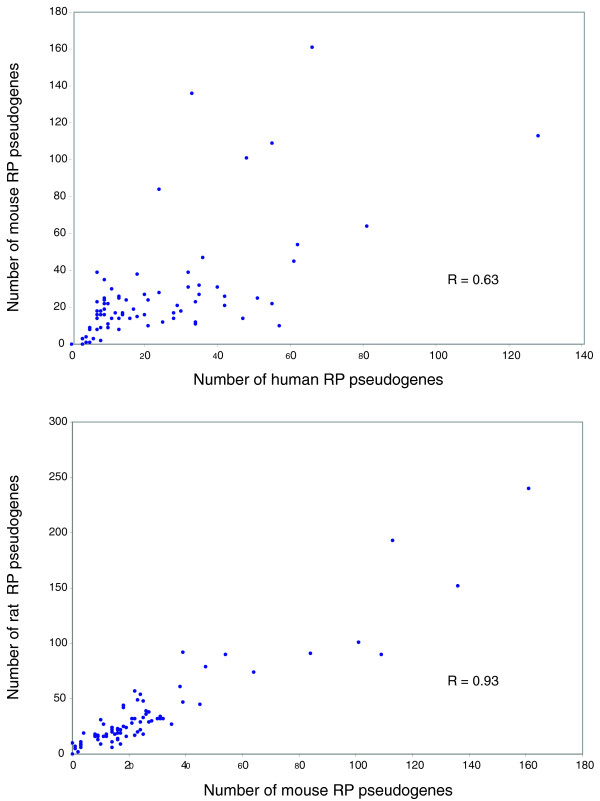
Plots depicting the number of processed pseudogenes associated with a RP protein in one organism and its corresponding ortholog in another organism. The top panel shows the comparison between human versus mouse and the bottom panel depicts the same for mouse versus rat RP pseudogenes. Each point corresponds to the number of processed RP pseudogenes associated with one RP in the two species that are being compared.